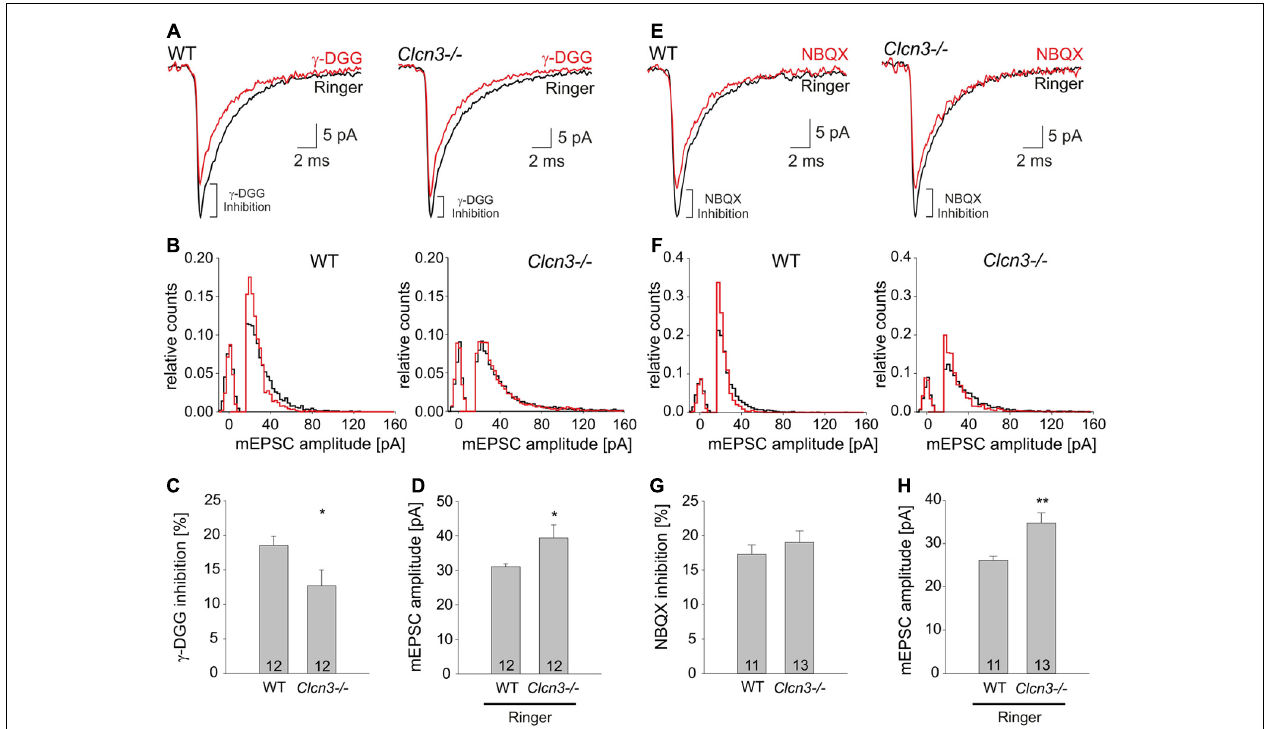
FIGURE 2 |The low-affinity competitive AMPA receptor antagonist γ -DGG blocks mEPSC amplitudes more efficiently in WT than in Clcn3 − / − neurons. (A) Ensemble mEPSC averages from WT (left) or Clcn3 − / − (right) neurons recorded in the absence (black trace) or in the presence of γ -DGG (red trace). (B) Peak mEPSC amplitude distributions for WT (left) and Clcn3 − / − (right), in the absence (black) or in the presence of γ -DGG (red). (C) Relative γ -DGG induced mEPSC amplitude reductions for WT and Clcn3 − / − . (D) mEPSC amplitudes from WT and Clcn3 − / − neurons in the absence of γ -DGG. (E) Ensemble mEPSCs